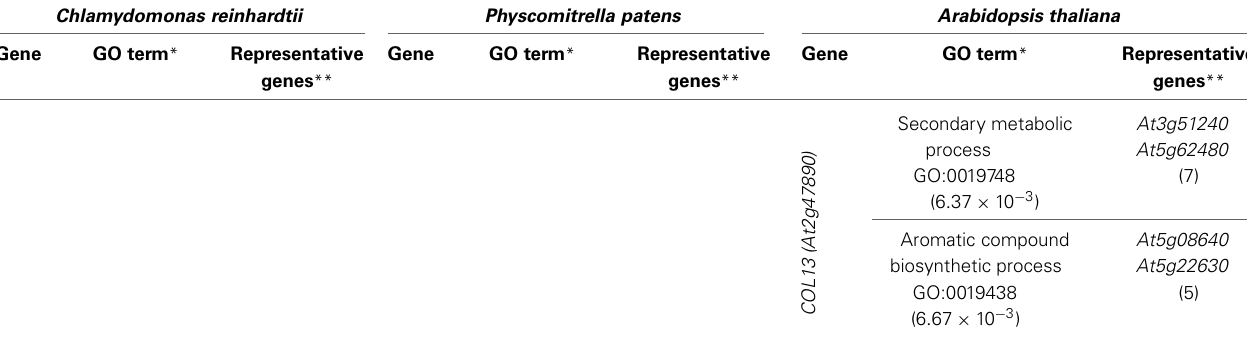
corresponding genes, while white cell indicate absence of correlation. Group A have retained CrCO ancestral functions related to light response and carbon metabolism (PpCOL1, COL7, COL5, COL2, and COL1). Group B is significantly correlated with chemical response and developmental processes (CO, PpCOL4, and PpCOL5). Some connection between groups is still observed. Functional classification coincides mostly with phylogeny with exceptions like COL1 and CO, phylogenetically very close but functionally very different. In contrast, CO, PpCOL4, and PpCOL5 are very divergent phylogenetically but seem to have functionally